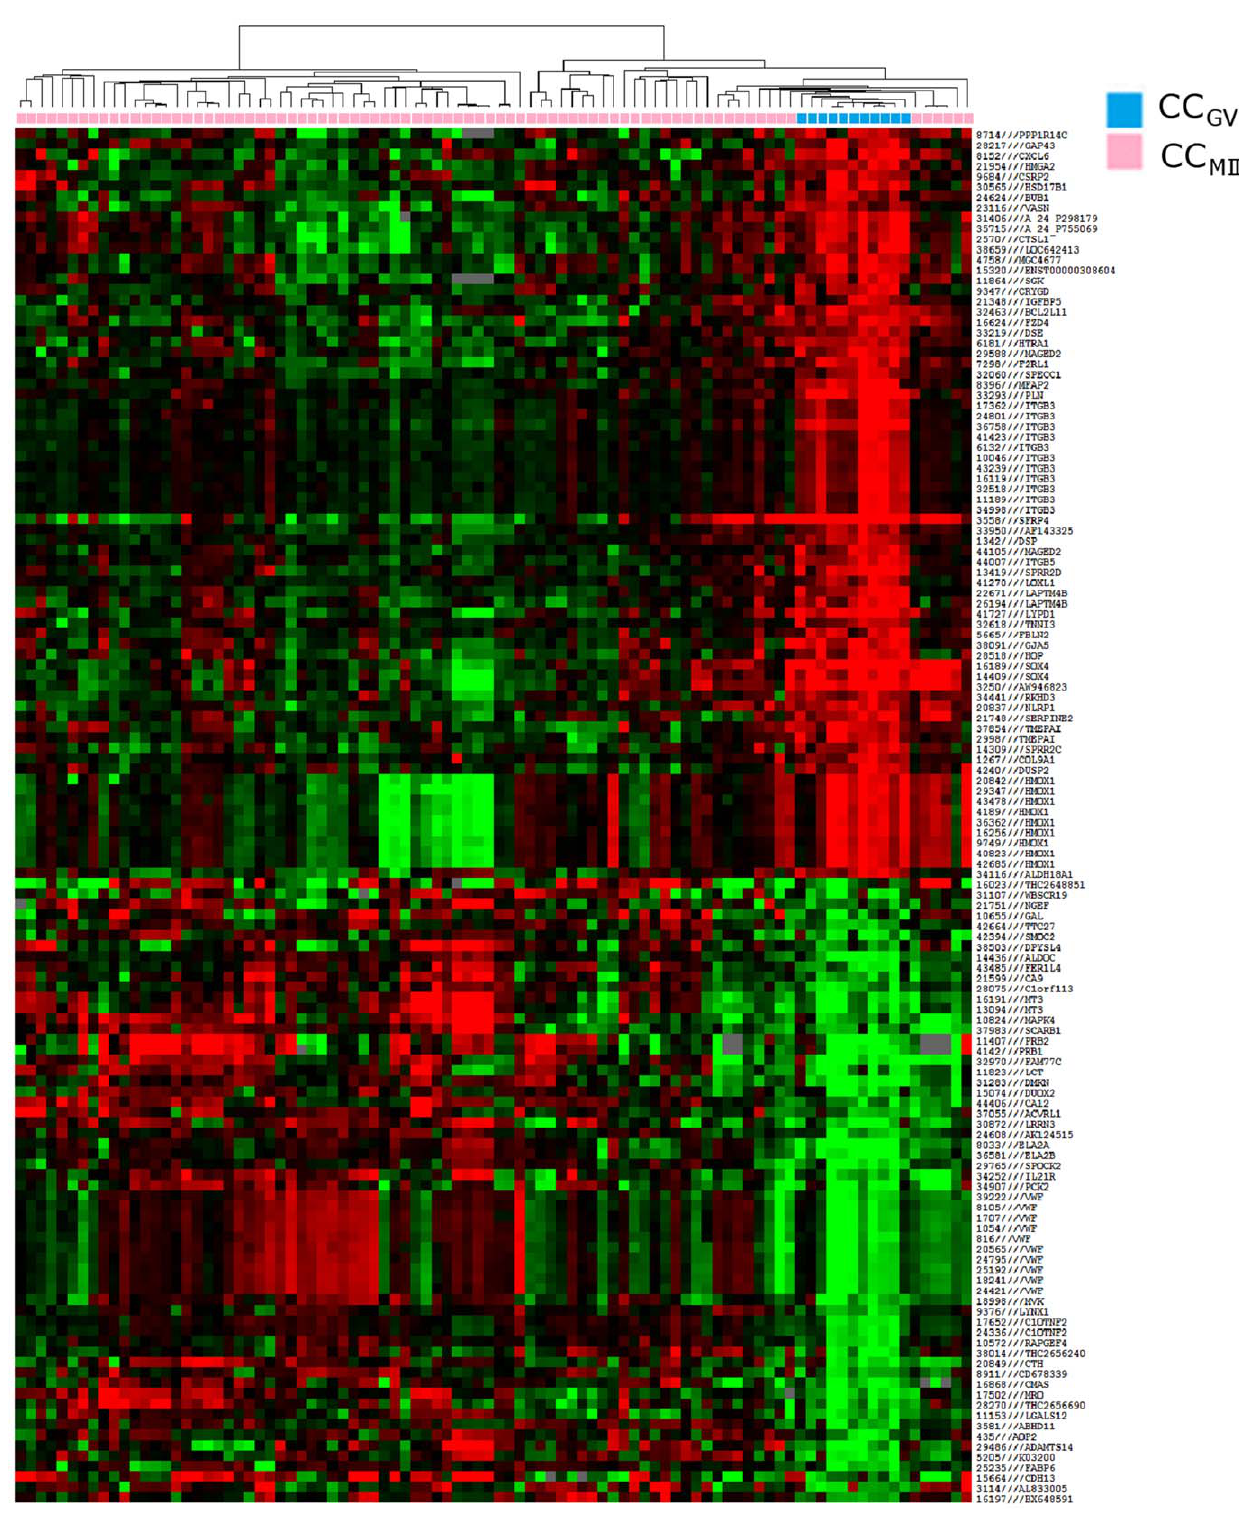
Figure 2. Heat map and cluster dendograms of gene clusters differentially expressed according to oocyte nuclear maturity. Hierarchical clustering of cumulus cell samples (columns) and the 132 most significant probes (rows). Upregulated genes are marked in red, downregulated genes are marked in green. CC GV (blue), cumulus cells from immature oocyte at germinal vesicle stage; CC MII (pink), cumulus cells from mature oocyte.